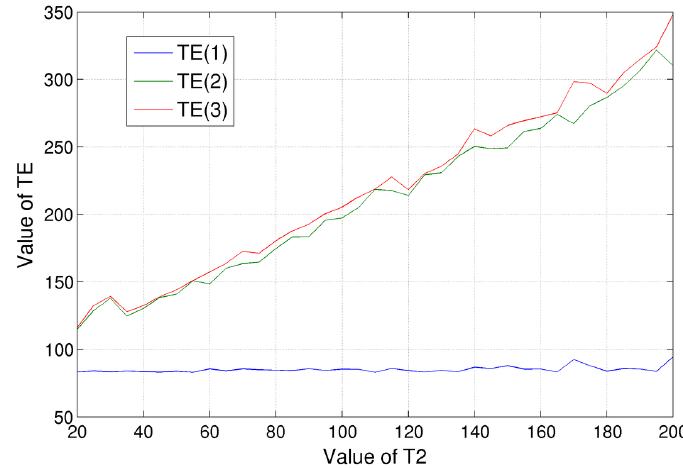
Figure 5. T values that minimize the CRLB of T E relaxation times, T . Three values have been considered: the blue line is for the lowest T 2 value, the red line for the highest one and green for the intermediate